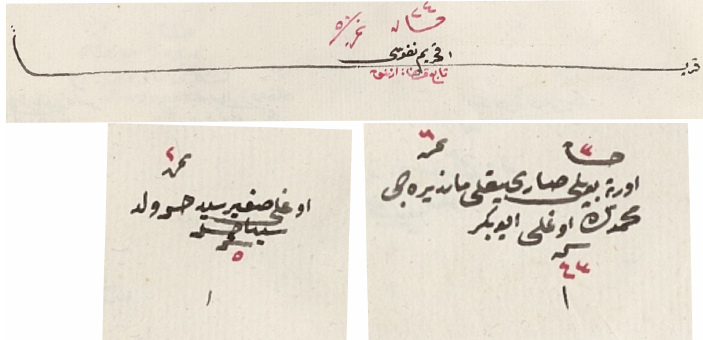
Figure 1. A population start, an individual and a household image samples are demonstrated. In the top, the populated place starting object, in the right bottom, a household and in the left bottom of the image, an individual object is